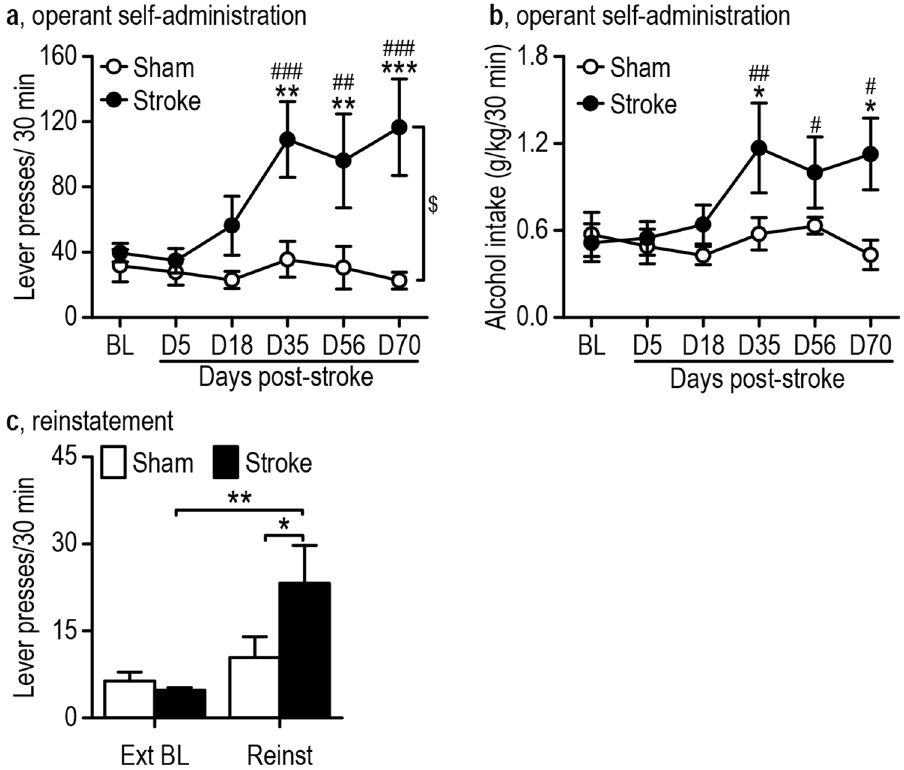
Figure 2. Ischemic stroke enhances operant alcohol self-administration and relapse. Sprague-Dawley rats were trained to consume 20% alcohol in operant chambers until a steady baseline (BL) was established. Stroke or sham control surgery was performed as described in the Experimental Procedures section. ( a ) Ischemic stroke resulted in significantly more lever presses on D35, D56, and D70 post-stroke as compared to sham or BL levels. $ p < 0.05, two-way RM ANOVA; ** p < 0.01 and *** p < 0.001 compared to sham by post-hoc SNK test; ## p < 0.01 and ### p < 0.001 compared to stroke BL by post-hoc SNK test. n = 6 (sham) and 5 (stroke)